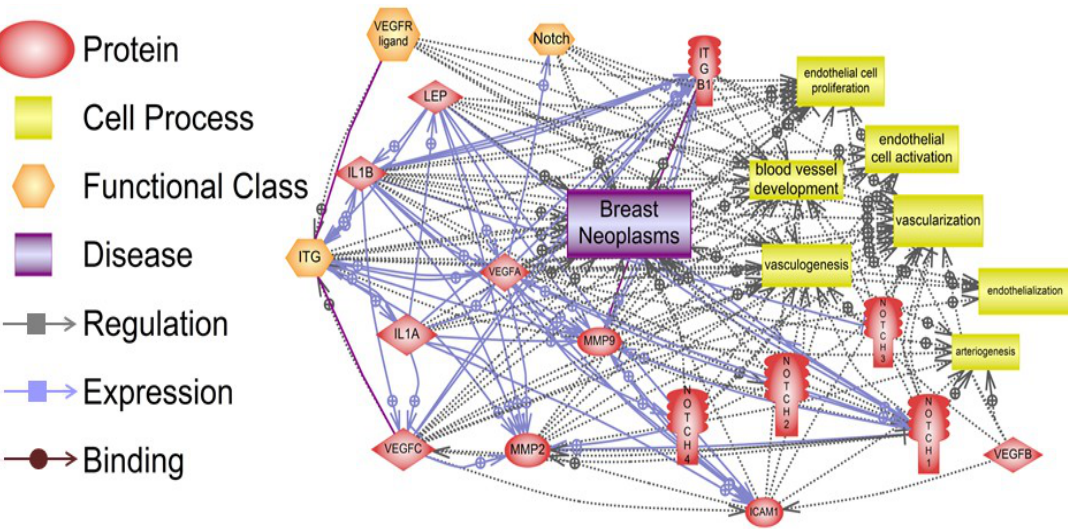
Figure 2. Relationships between pro-angiogenic effects of leptin signaling and breast neoplasms, vascularization, and endothelial cell function. Many signaling pathways show the connections between regulation, expression and binding of leptin, IL-1, adhesion molecules (ICAM and integrins), Notch, VEGF/VEGFR and MMPs and, their impact on vessel development and endothelial cell function, which are essential for breast neoplasm development. The summary of the data processed by the Program Studio 9 [19] and specific molecular and cellular relationships can be found in the supplementary material. Notes: ITG (integrins); ITGB1 (integrin β1); IL-1A and B (IL-1α and β); Lep (leptin); ICAM (CD54, intercellular adhesion molecule